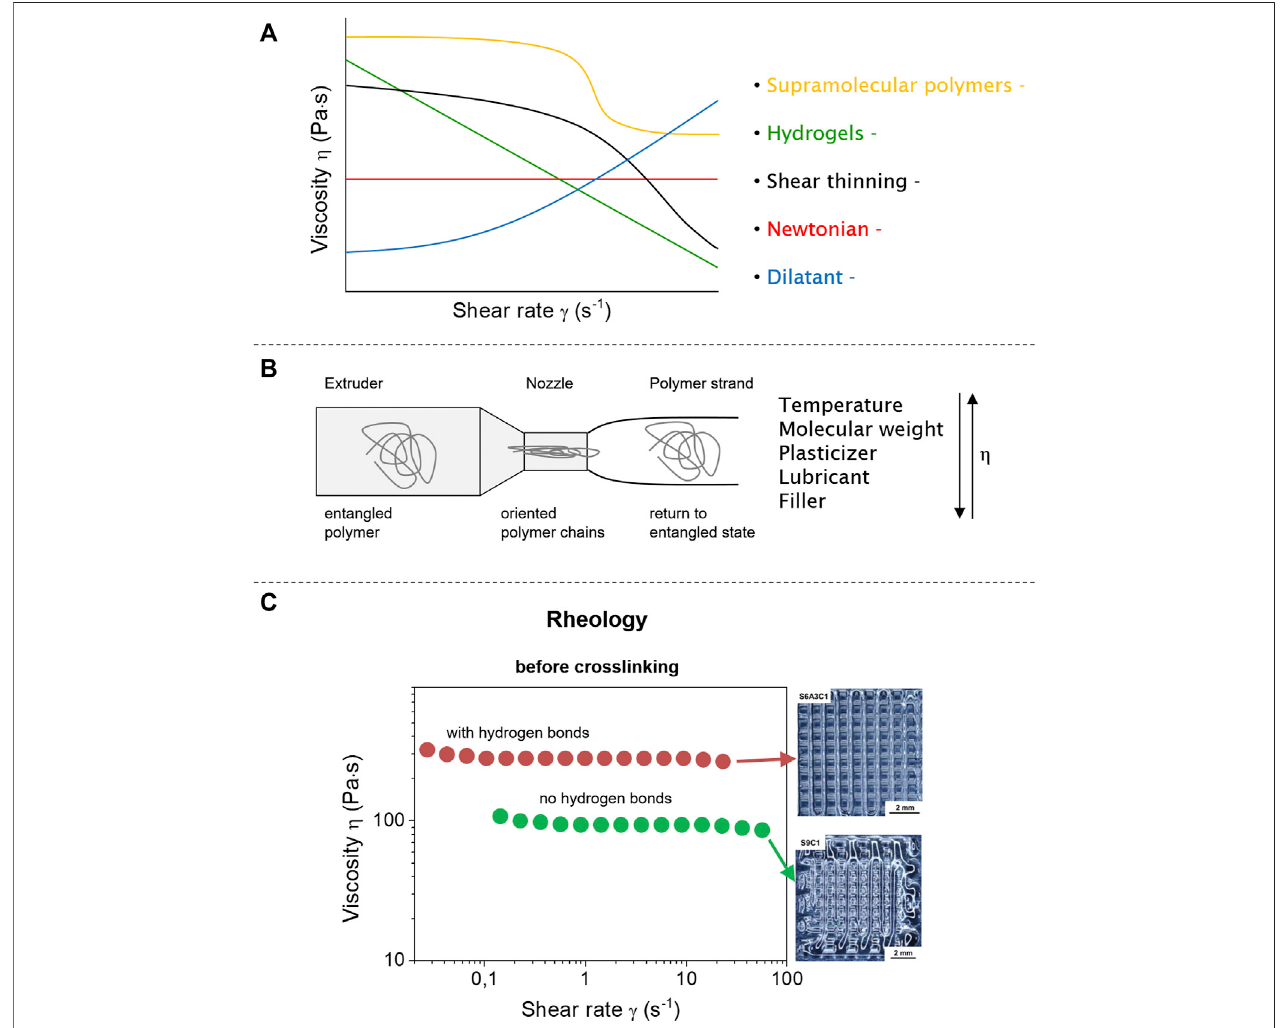
FIGURE2| Flowbehaviorofdifferent fl uidsystems(Newtonian,dilatant,andshearthinning)andpolymermaterials(supramolecularpolymersandhydrogels)under shear force (A) . Polymers will be under shear stress during extrusion that leads to deformed and oriented polymer chains (B) . Supramolecular interactions change the fl ow properties compared to neat polymer materials improving the form stability after extrusion (C) . Reproduced with permission (Liu et al., 2020). Copyright 2020, American Chemical Society.